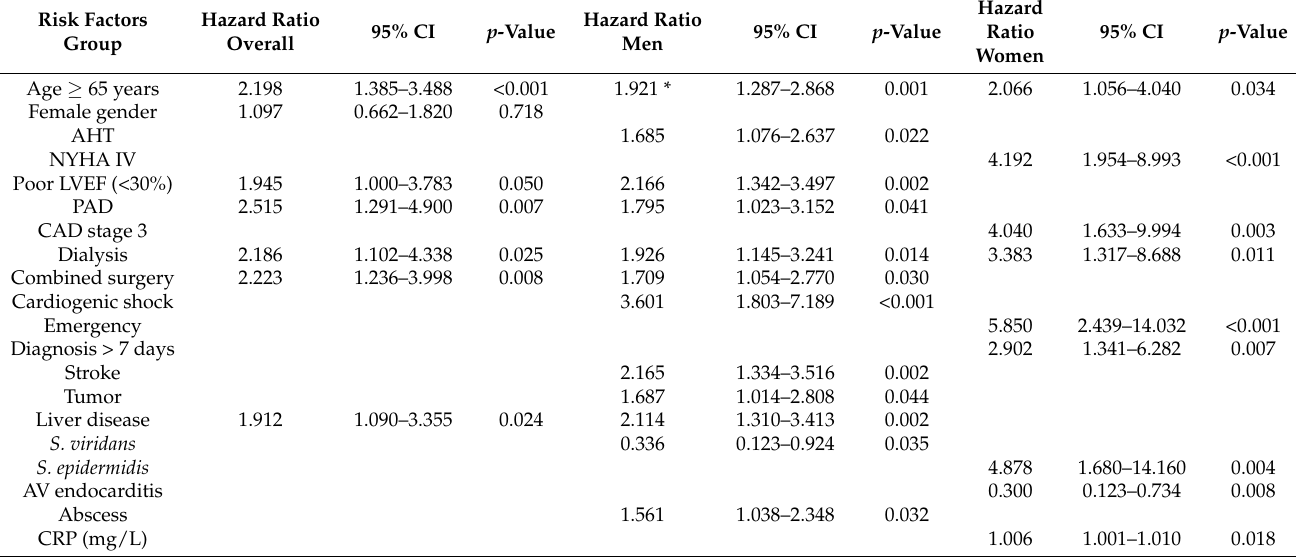
Table 5. Independent preoperative risk factors for mortality during